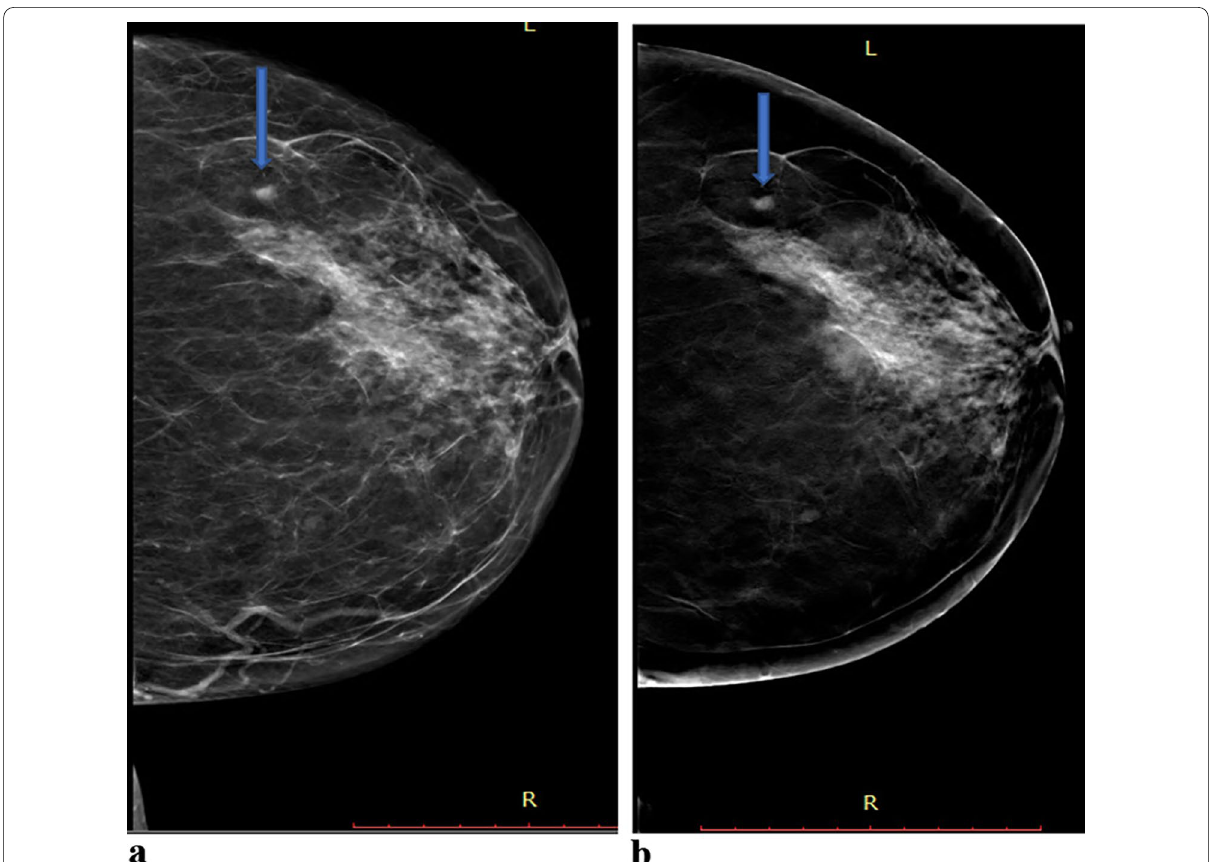
Fig. 7 A 52-year-old female complained of left axillary mass. a CC view of 2DDM of the left breast shows Scattered fibro-glandular densities (ACR b). b CC view of DBT of the left breast. Left breast shows small irregular shaped dense mass in outer quadrant with speculated margin best appreciated in DBT. BIRADS 4, proved by histopathology to be invasive ductal